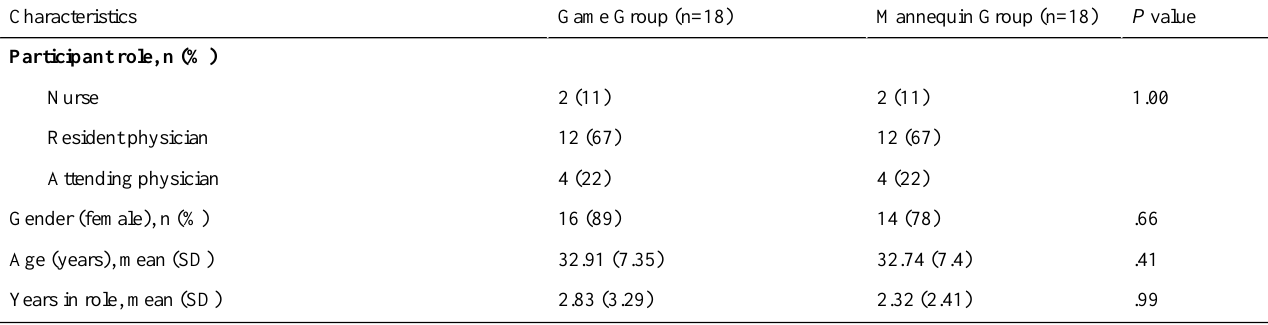
Table 1. Demographics of participants in the simulation (Mannequin Group) and serious game (Game Group) arms of the randomized controlled trial.